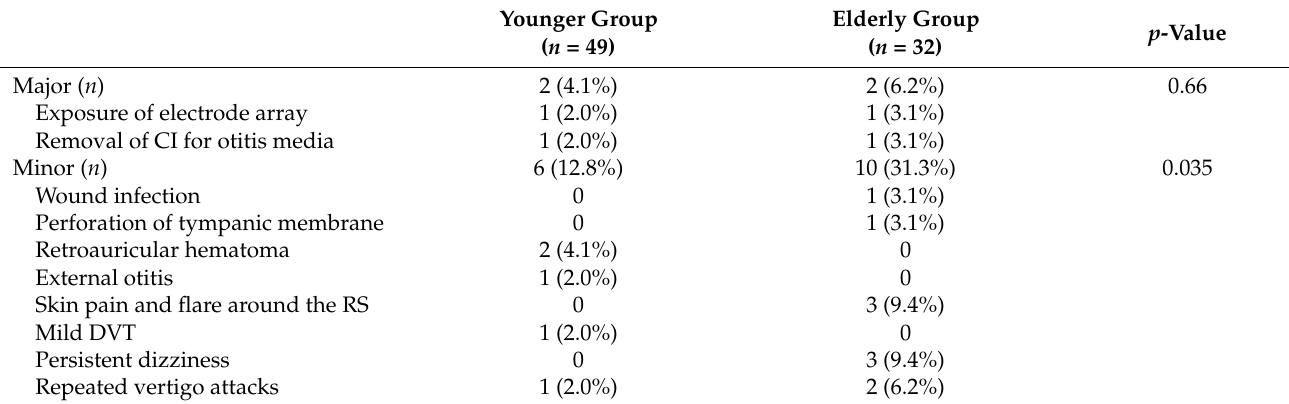
Table 2. Incidence of postoperative complications.